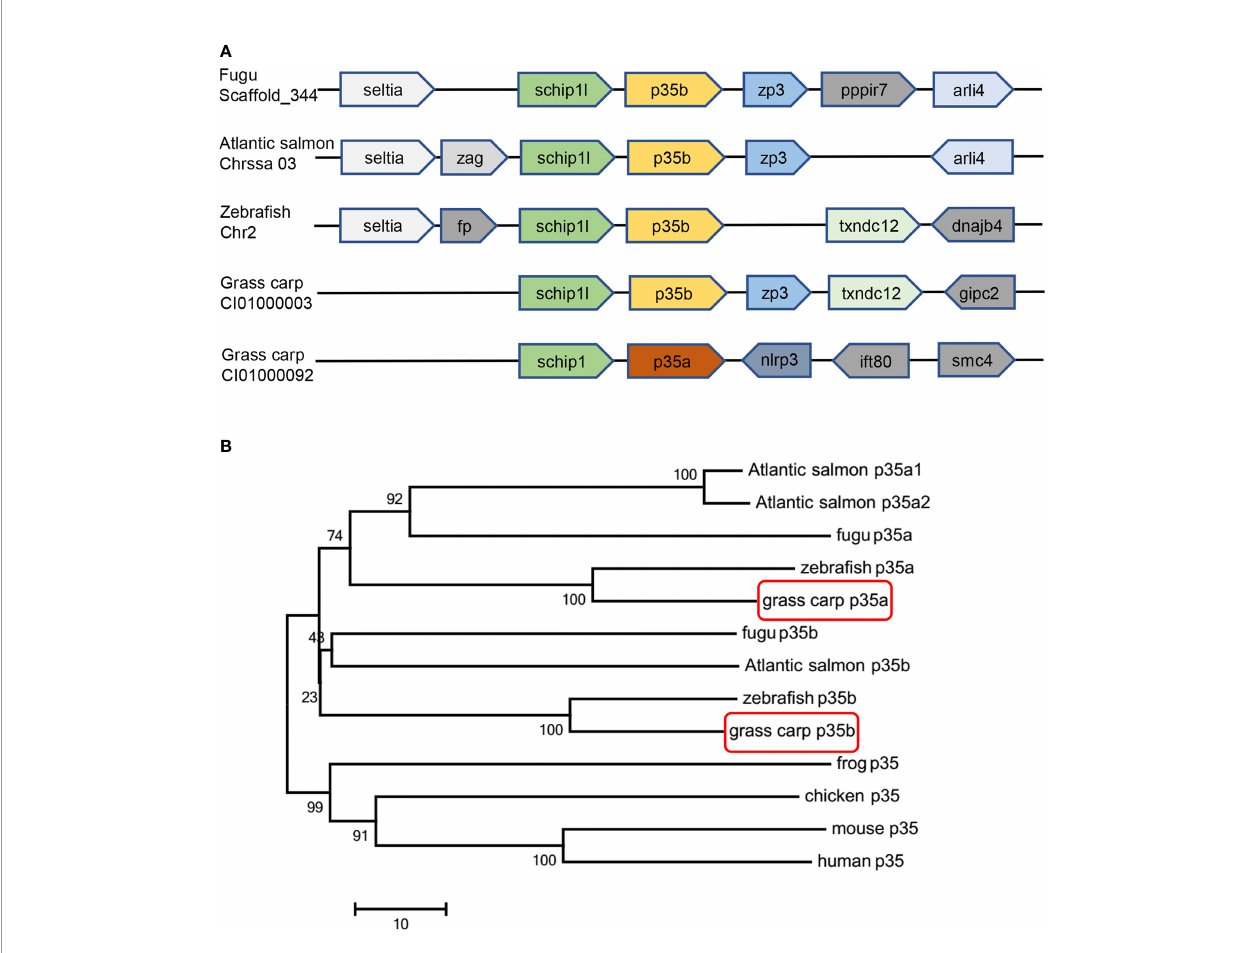
FIGURE 1 | Gene synteny and phylogenetic tree analysis of p35 homologues. (A) Gene synteny analysis of grass carp p35a , grass carp p35b , fugu p35b , zebra fi sh p35b , and Atlantic salmon p35b . The direction of the box arrow indicated gene transcription orientation. (B) An unrooted phylogenetic analysis of p35 amino acid sequences in various vertebrates. The tree was constructed by the neighbor joining method by using MEGA 7 software. The numbers indicate the bootstrap con fi dence values obtained for each node after 1000 replications. The GenBank accession numbers of p35 are as follows: human (NM_000882), mouse (NM_008351), chicken (NM_213588), frog (XM_012963291), fugu p35a (H2SI185), fugu p35b (NM_001078598), Atlantic salmon p35a1 (HG917954.1), Atlantic salmon p35a2 (HG917955.1), Atlantic salmon p35b (HG917956.1), zebra fi sh p35a (NM_001007107), zebra fi sh p35b (XM_017352586), grass carp p35a (KF944667) and grass carp p35b